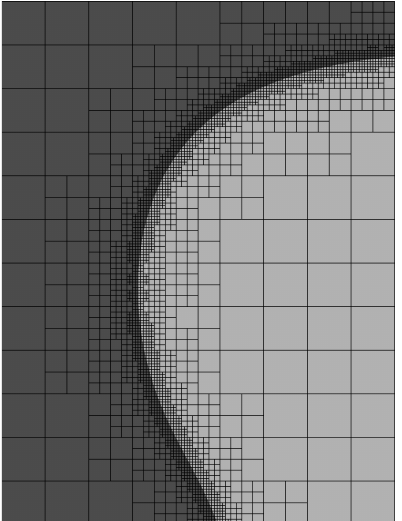
Figure 32. Zoom in Figure 31 at t = 140, as marked by red rectangles.